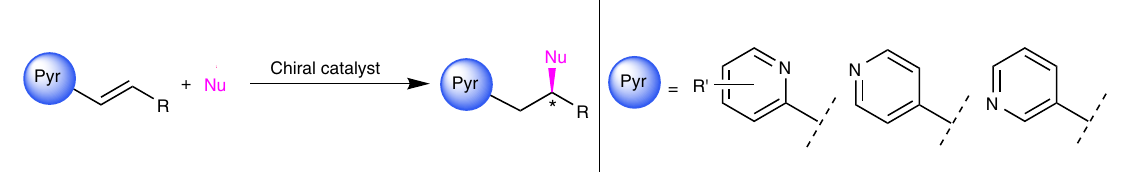
Fig. 1 Enantioselective nucleophilic addition to alkenyl